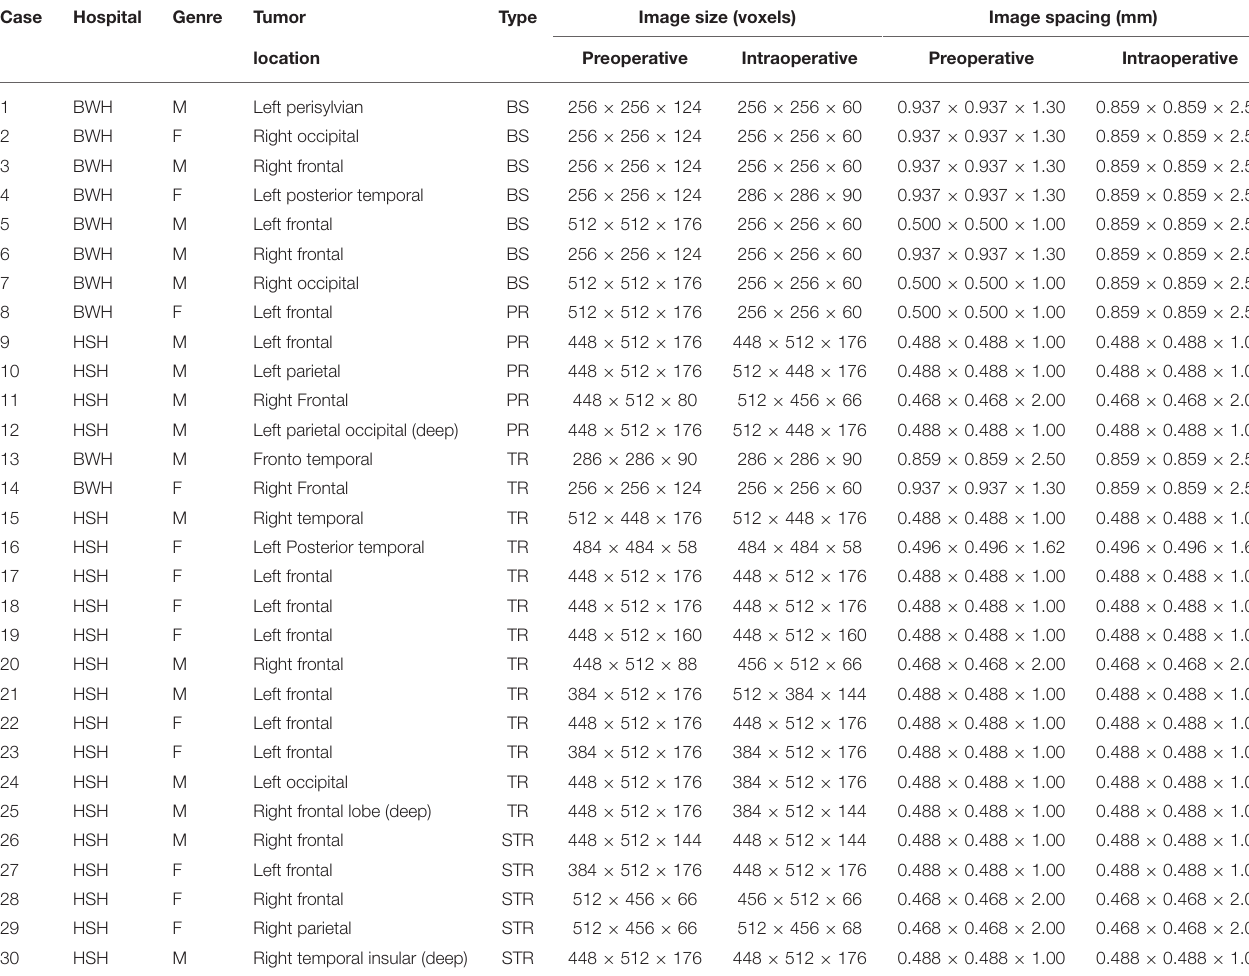
TABLE 1 | Clinical MRI